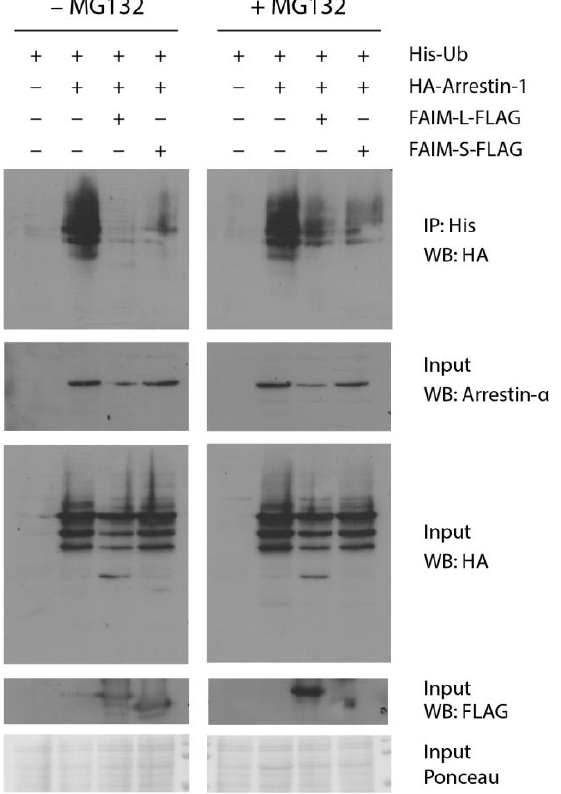
Figure 8. FAIM-S and FAIM-L block Arrestin-1 ubiquitination in vitro. HEK293T cells were trans- fected with the described plasmids, in the presence or absence of MG132 treatment, as indicated. Successful transfection was confirmed by immunoblotting for HA and FLAG for Arrestin-1 and both FAIM-L and FAIM-S expression, respectively. Ponceau staining was used to check protein loading. Ubiquitin-His pull-down were run in a gel and immunoblotted for HA. Evident ubiquitination is observed in the condition were Arrestin-1 is expressed alone with ubiquitin, and a signifi- cant decrease of ubiquitin is found in both conditions in which FAIM-L and FAIM-S are overex- pressed. Data are representative of three independent experiments.